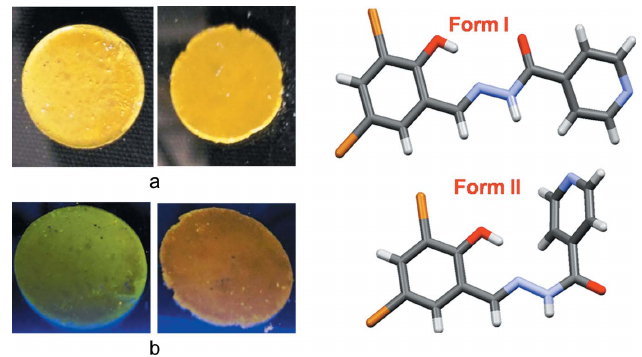
Figure 15 (Left) Compound-B Form I and Form II ( a ) under normal light and ( b ) under UV at 365 nm. (Right) The variation in the conformation of the